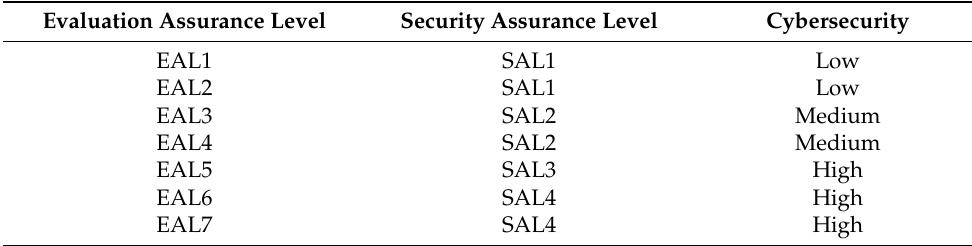
Table 4. Levels of cybersecurity (EALs and SALs).